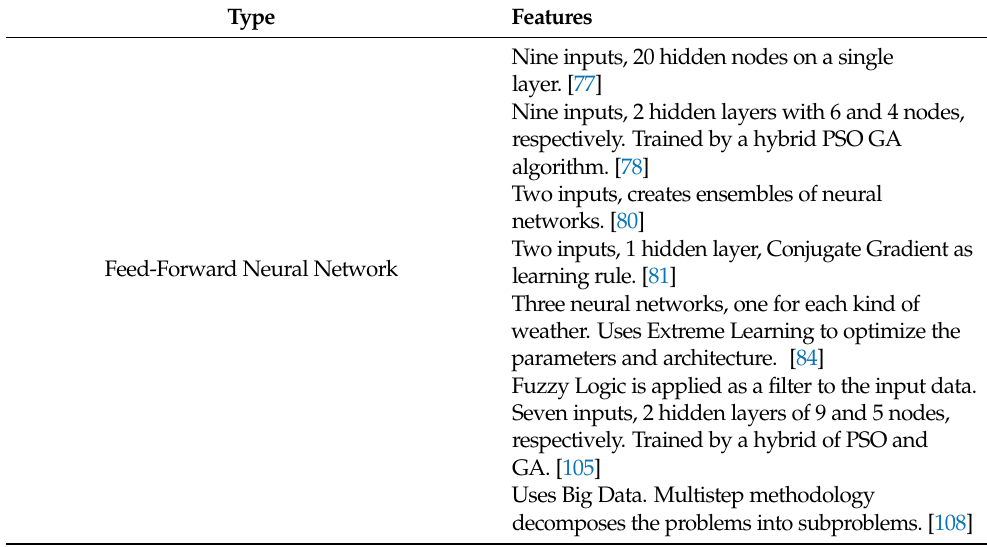
Table 5. Models for